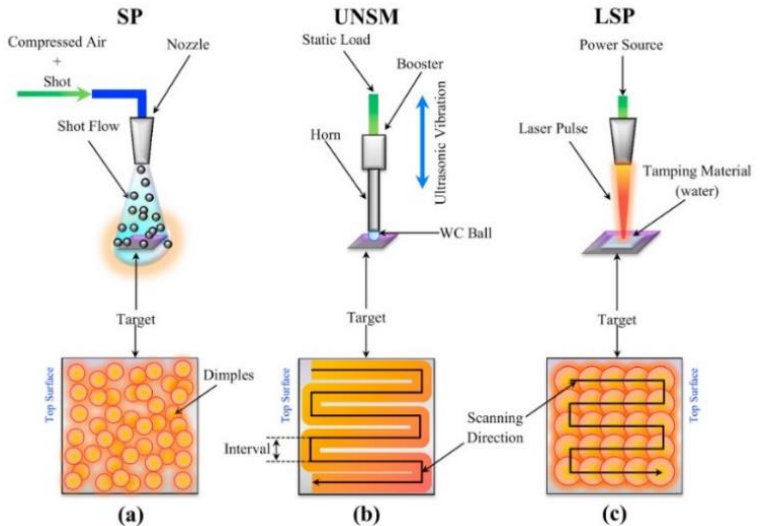
Figure 4. Schematic illustration of different surface SPD treatments and the corresponding plas- tically de-formed top surface of the target material: ( a ) SP, ( b ) UNSM, and ( c ) LSP processes (reproduced with permission from Ref. [46], Copyright 2021,